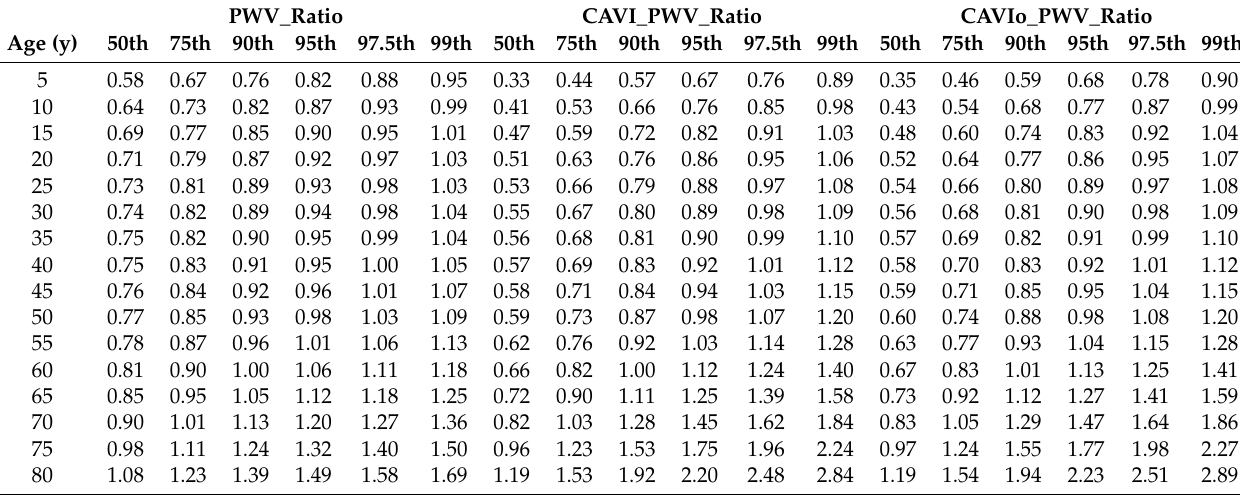
Table 13. PWV Ratio levels and related parameters (CAVI and CAVIo) reference intervals: